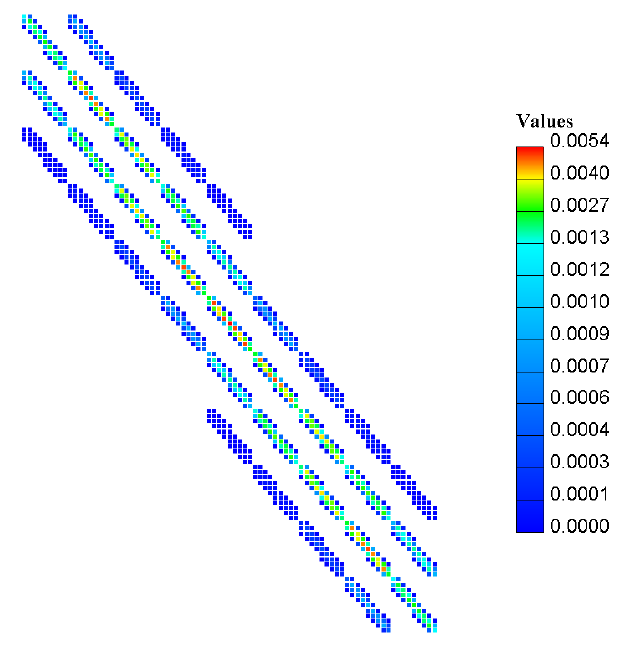
Figure 6. The mortar projector is a sparse